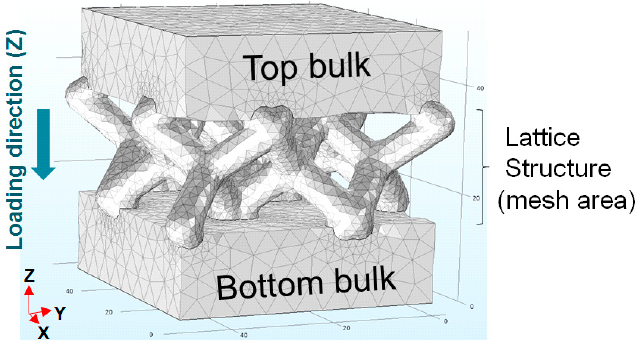
Figure 1. The image of a mesh-type sample having a lattice structure and solid bulk pads at the top and bottom. We also conducted computational analysis with the conditions shown in Table 1, in order to predict stress distribution and fracture under uniaxial-loading. To reveal the correlation of lightweight degree and strength, the volume ratio ( ρ / ρ 0 ) is particularly defined as the lightweight-designed volume ( ρ ) divided by the initial cubic volume ( ρ 0 ) in this study. In this work, all graphs were plotted by Microsoft Excel software (Redmond, DC, USA). COMSOL Multiphysics software (ver.5.2, Burlington, MA, USA) also was used for computational analysis. No data analysis has been performed as each test was conducted twice for data accuracy. Tests have been conducted only two times as the difference between the two measures has been recorded to be very low. Table 1. Analytical methods and conditions used in computer numerical analysis.